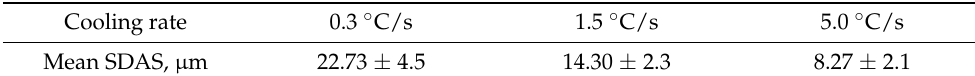
Table 1. Mean values of SDAS measured in di ff erent cooling rate samples.